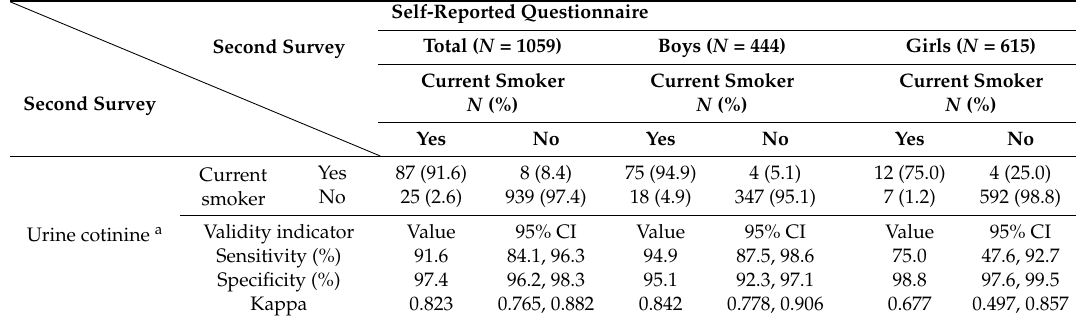
Table 2. Validity evaluation of self-reported current cigarette smoking prevalence within the second survey.